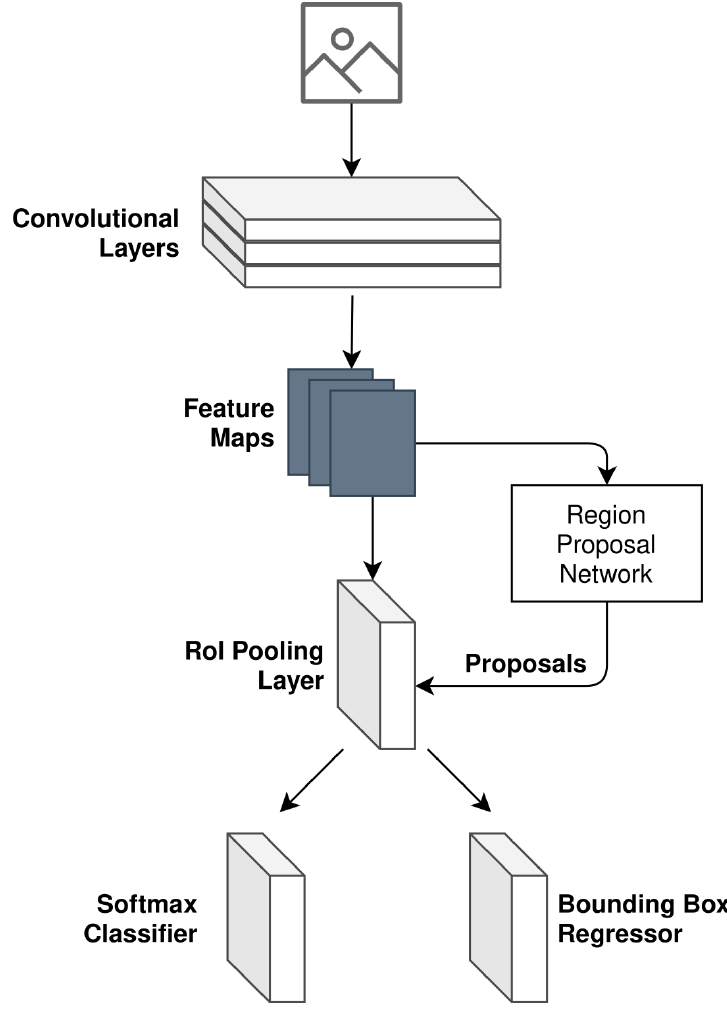
Figure 7. Faster R-CNN model design as used for camera object